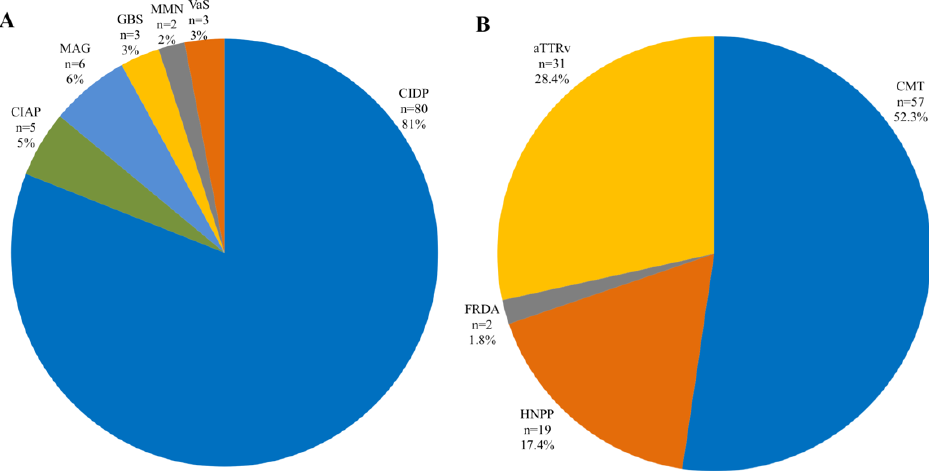
Figure 2. Prevalence of polyneuropathy subtype in inflammatory ( A ) and hereditary ( B ) polyneuropathies. CIDP, chronic inflammatory demyelinating polyneuropathy; CIAP, chronic inflammatory axonal polyneuropathy; MAG, myelin-associated glycoprotein; GBS, Guillain–Barr é syndrome; VaS, vasculitis; ATTRv, hereditary transthyretin amyloidosis. CMT, Charcot–Marie–Tooth. HNPP, hereditary neuropathy with liability to pressure palsies; FRDA, Friedreich ataxia. From a total of n = 268 participants, 258 (96.3%) were fully vaccinated against SARS- CoV-2 (102 F; median age 59 years (48–68)), while n = 10 (3.7%) did not receive the vacci- nation (3 F, median age 60 years (53–68)), without difference in gender and between